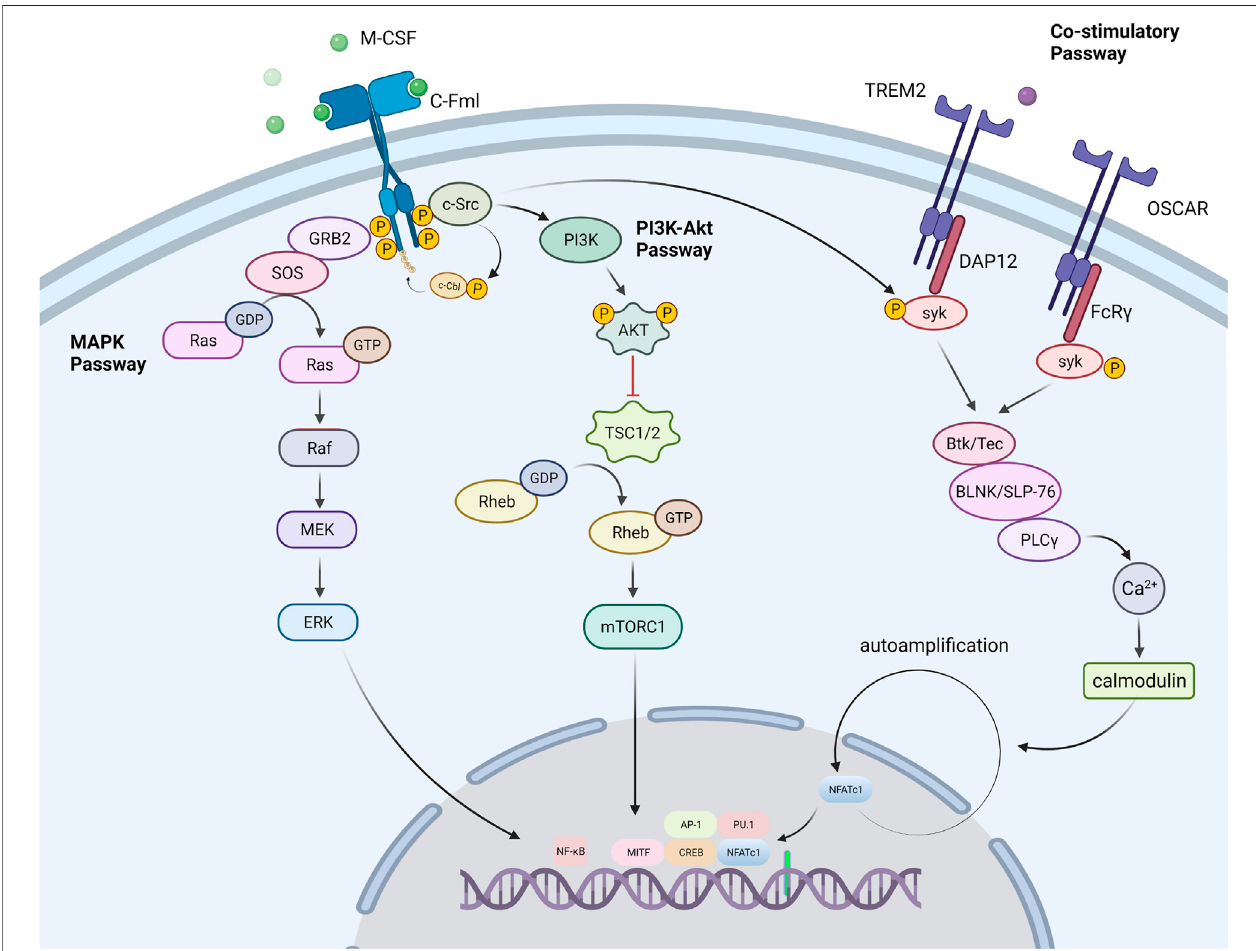
FIGURE2| SignalpasswaysintheprocessofosteoclastogenesisunderthestimulationofM-CSF.PI3K-Aktpathway:M-CSFbindstoitsreceptorc-Fms,induces partial phosphorylation of key sites in the c-Fms tail, and recruits the tyrosine kinase c-Src. The partially phosphorylated receptor binds to c-Src to form a c-Fms/c-Src Protein complex. Then the complex recruits E3 ubiquitin ligase (c-Cbl) and causes it to undergo tyrosine phosphorylation. As a response, the phosphorylated c-Cbl causes receptor ubiquitination, which further causes the receptor to be completely phosphorylated. Subsequently, the c-Fms/c-Src protein complex recruits phosphatidylinositol 3-kinase (PI3K) to trigger the PI3K-Akt pathway for OCPs activation and proliferation. MAPK pathway: After the receptor was stimulated, the receptorassociatedGrb2/SosactivatestheMAPKsignalingcascade,whichconclusivelyleadstothephosphorylationandactivationoftheextracellularsignal-regulated kinase (ERK) to promote the formation of osteoclasts. Co-Stimulatory pathway: M-CSF also promotes the co-stimulatory pathway of nuclear factor activated T cells 1 (NFATc1). M-CSF can activate the Fc receptor common gamma subunit (FcR γ ) and dnax activation protein 12 (DAP12), which further activate the tyrosine kinase Syk. SykformsacomplexwithBtk/Tec,BLNK/SLP76.ThecomplexfurtheractivatesPLC γ ,initiatesthePLCpathway,anddephosphorylatesthetranscriptionfactorNFATc1 to promote its entry into the nucleus and induce the differentiation of precursor cells into osteoclasts.